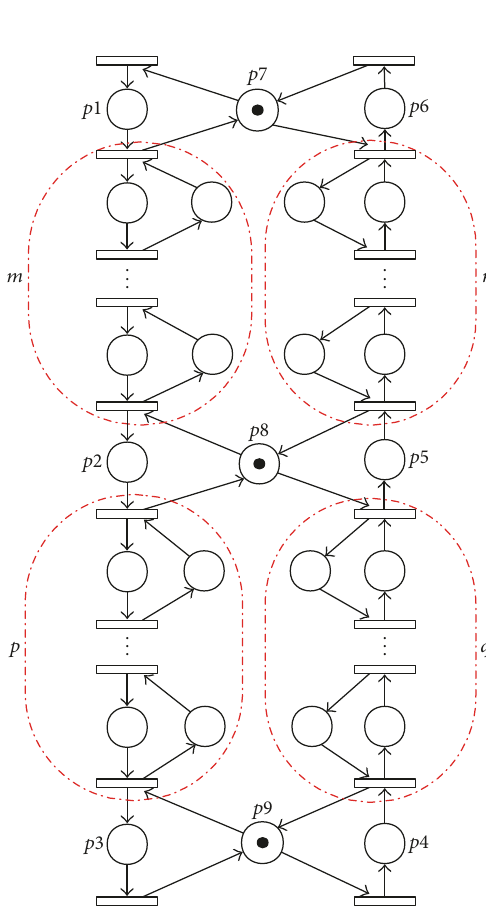
Figure 7: Simulation results of Figure 6.